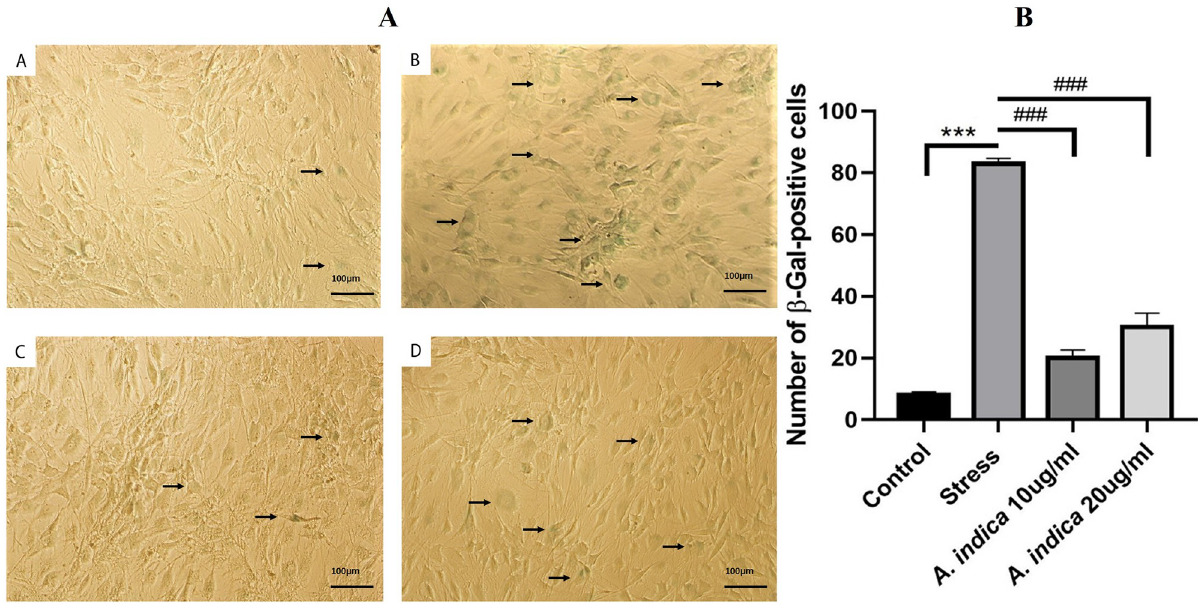
Fig 3. Cytoprotective effect of A . indica extract against MIA induced senescence in human adipose stem cells. A. (1) Control (2) 10 μ M MIA (3) 10 μ g and (4) 20 μ g A . indica extract preconditioned hADMSCs. Images were taken on at 100 μ m scale and 100x magnification. B. Bar graph represents number of senescence positive cells in each group. Analysis of number of senescence positive cells of each group was performed though ImageJ software while statistical analysis of the results was carried out through Prism software. Values are statistically significant at p � < 0.05, p �� < 0.01, p ��� < 0.001compared with the control group while p# < 0.05, p## < 0.01, p### < 0.001 compared with stress group. The experiment was carried out in triplicates (n = 3).